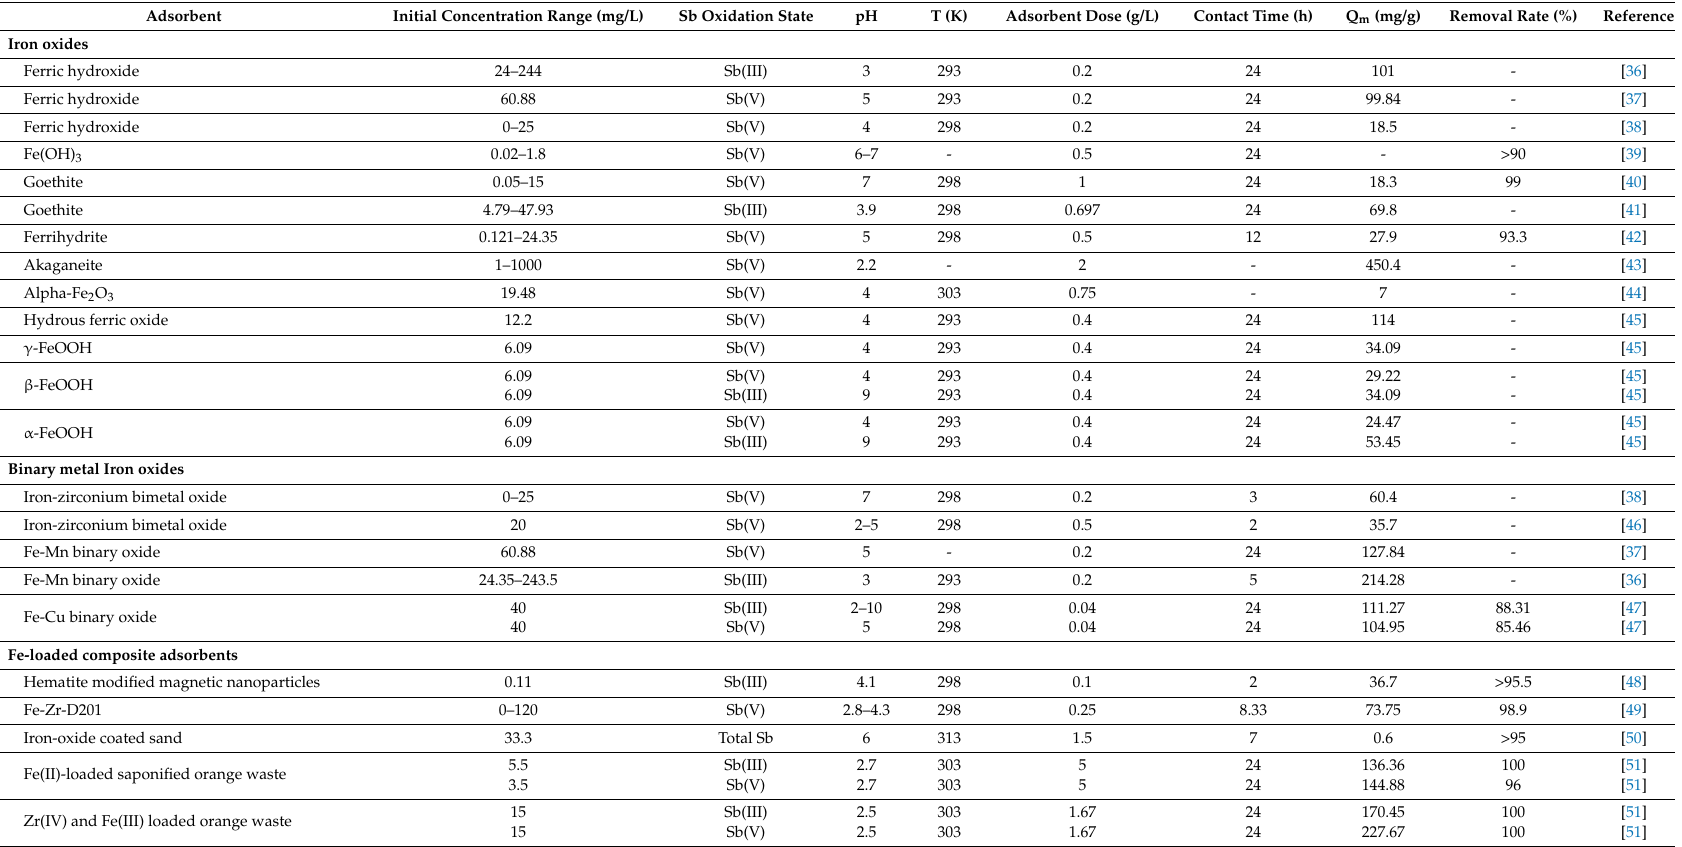
Table 1. Maximum adsorption capacities (Q m ) reported in literature for antimony removal from aqueous solutions.